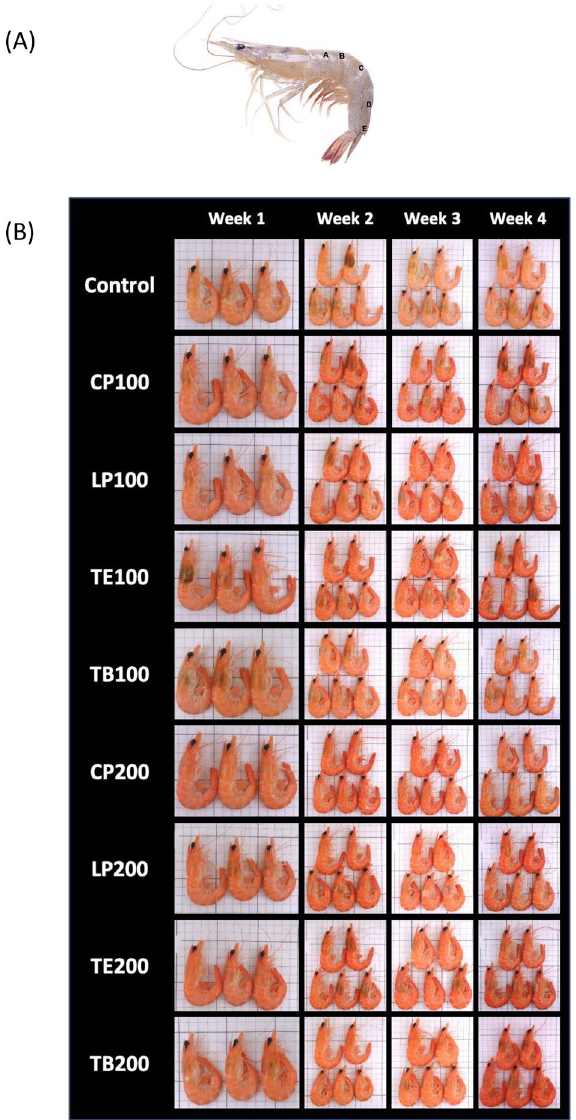
Figure 2. Effects of dietary AST on shrimp body colorization. ( A ) Digital analysis points of shrimp body, and ( B ) weekly photograph after